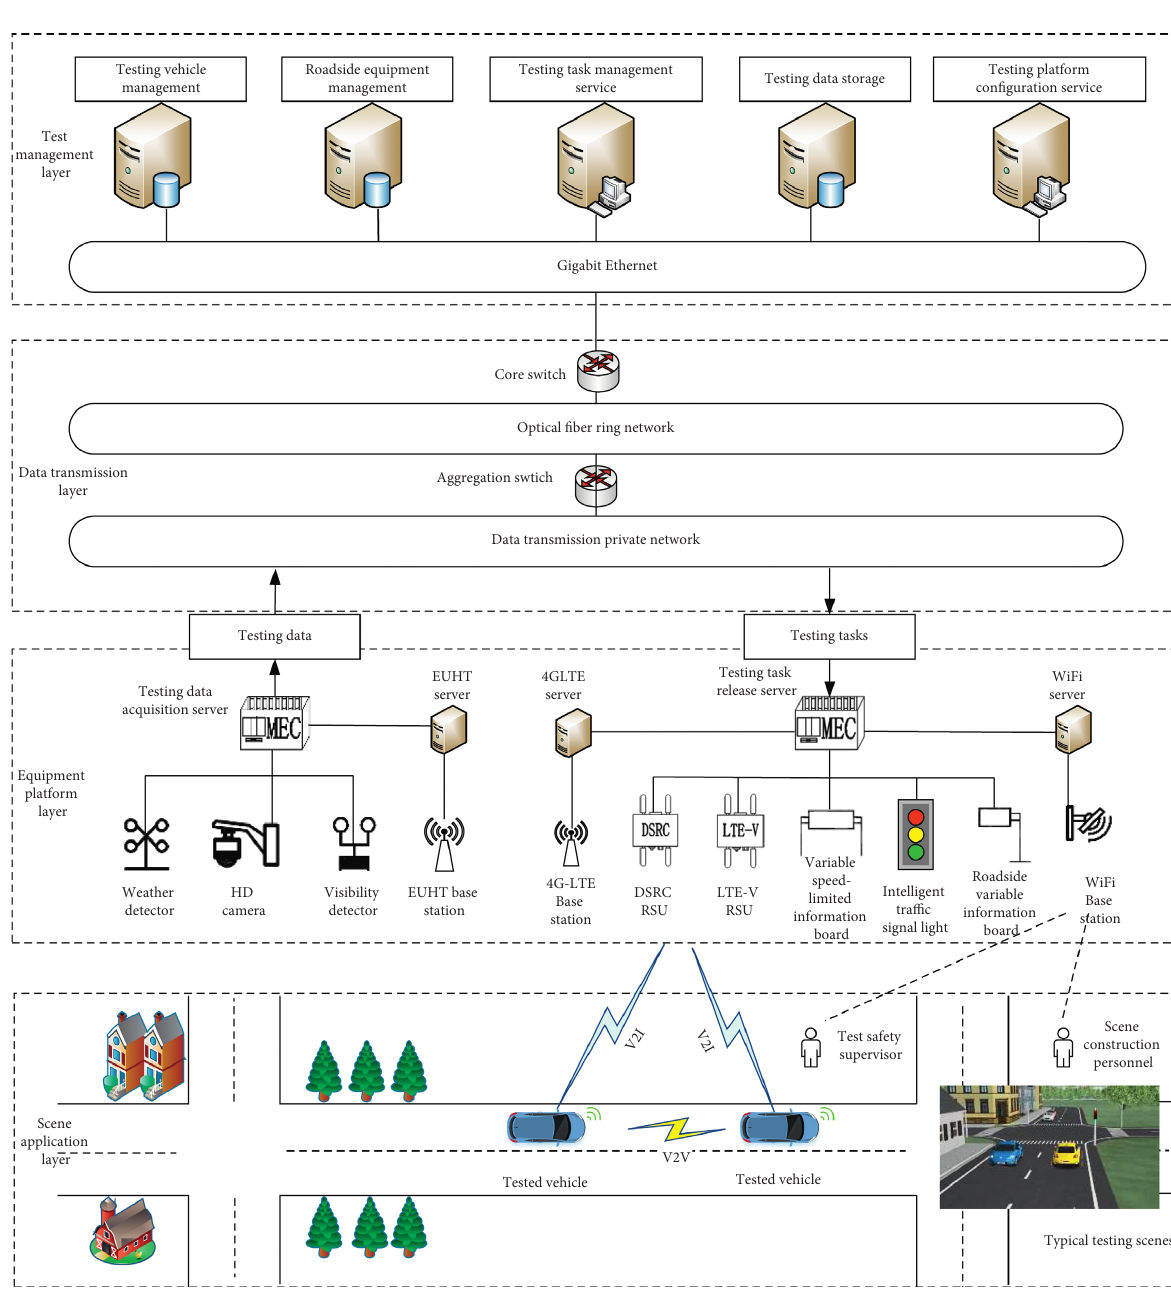
Figure 2: Modular testing platform for V2X performance and function testing.